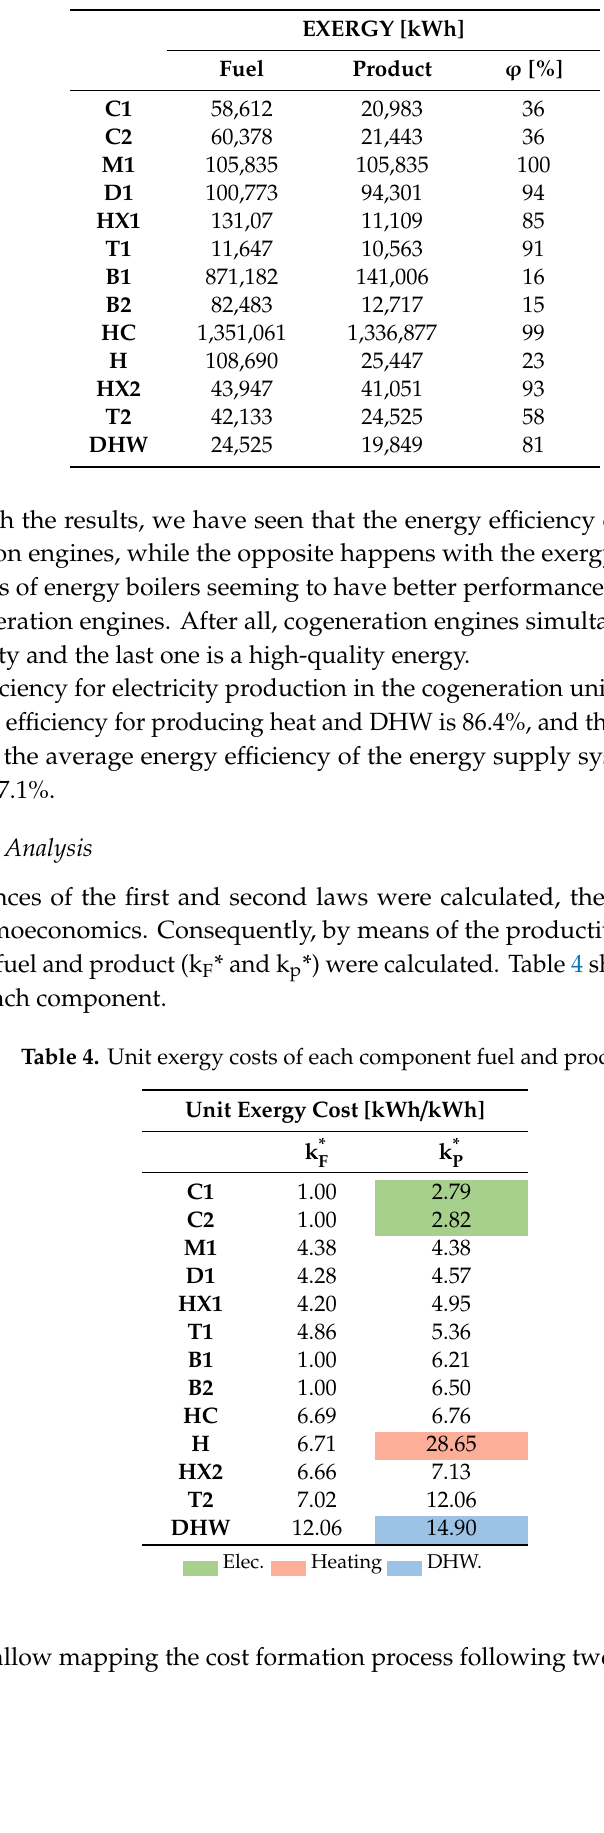
Table 3. Yearly exergy e ffi ciency of components.